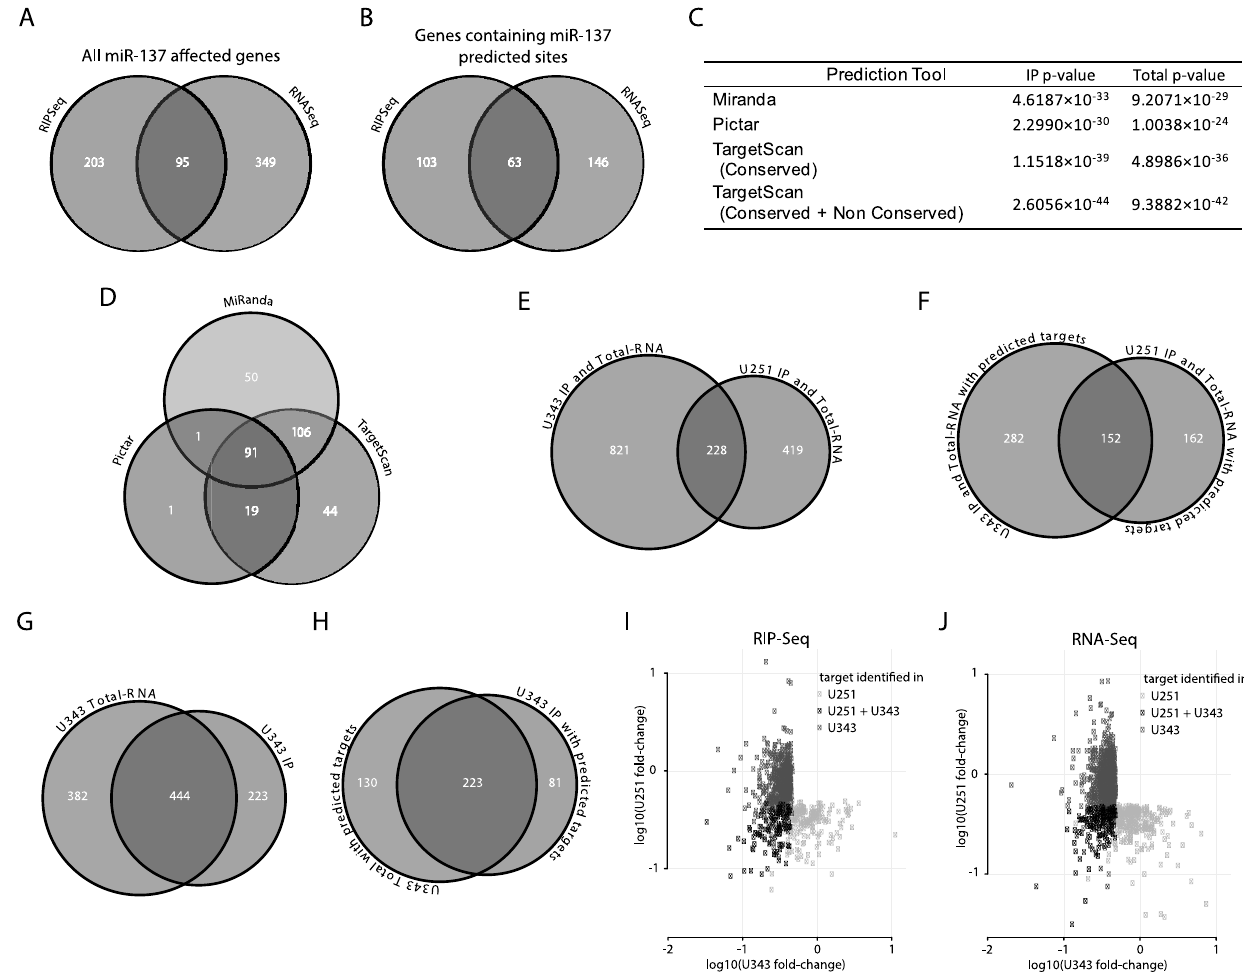
Figure 2. Analysis of miR-137 impact on glioblastoma expression by two genomic approaches. A ) Venn diagram shows the number of genes affected by miR-137 mimics transfection in U251 cells obtained by RNASeq and RIPSeq approaches. B ) Venn diagram shows the number of genes identified by our approaches containing miR-137 predicted targets according to TargetScan, Miranda or Pictar. C ) Hypergeometric test determined the significance of results of the two approaches used to identify miR-137 targets. D ) Venn diagram shows the distribution of genes containing miR-137 predicated sites (from B) according to prediction tools. E ) Venn diagram showing the number of genes identified by either the RIPSeq assay or the RNASeq assay in U251 cells, U343 cells, and both cell types. F ) As in panel E, but considering only genes that were predicted as miR137 targets by Miranda, Pictar or TargetScan. G ) Venn diagram showing the number of genes identified as miR137 targets in U343 cells by the RIPSeq assay, the RNASeq assay and both. H ) As in panel G, but considering only genes that were predicted as miR137 targets by Miranda, Pictar or TargetScan. I ) The average log10-fold-change in U251 cells (y-axis) and U343 cells (x-axis) is shown for all genes identified as miR137 targets by the RIPSeq assay in either U251 or U343 cells; genes (points) are colored by whether they were identified in only U251 cells, only U343 cells, or both. J ) As in panel I, but for the RNASeq assay. doi:10.1371/journal.pone.0085591.g002 nucleotides in base pairing. Most positions on the miR-137 binding region correspond to a less-than-average amount of structure – Figure S5A ; the only positions that have a significantly higher-than-average tendency of participating in intra-mRNA base pairing correspond to miR-137 positions 6, 7 and 17. These crucial for correct microRNA target recognition. Figure S5B shows the fraction of times, that a nucleotide of miR-137 interacts with its target mRNA via base pairing (according to computational predictions based on the RNAduplex program [38]). Nucleotide positions 3–8, corresponding to the miR-137 seed region, are predicted to be more frequently involved in microRNA-mRNA base pairing compared to other regions of the microRNA.